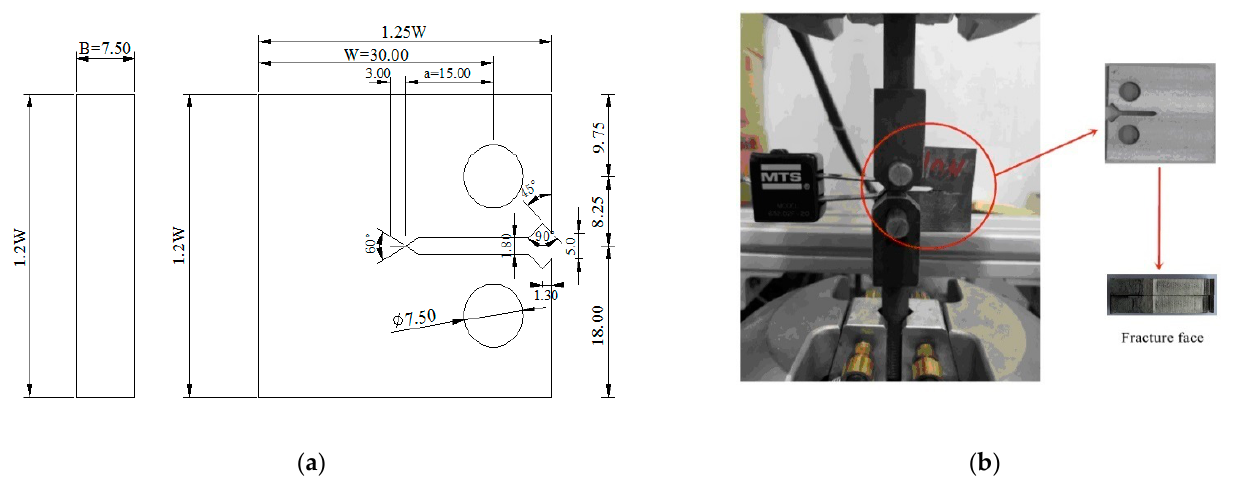
Figure 2. ( a ) Sketch and dimensions (mm) of compact tension (CT) specimen and ( b ) experiment process in CT specimen.